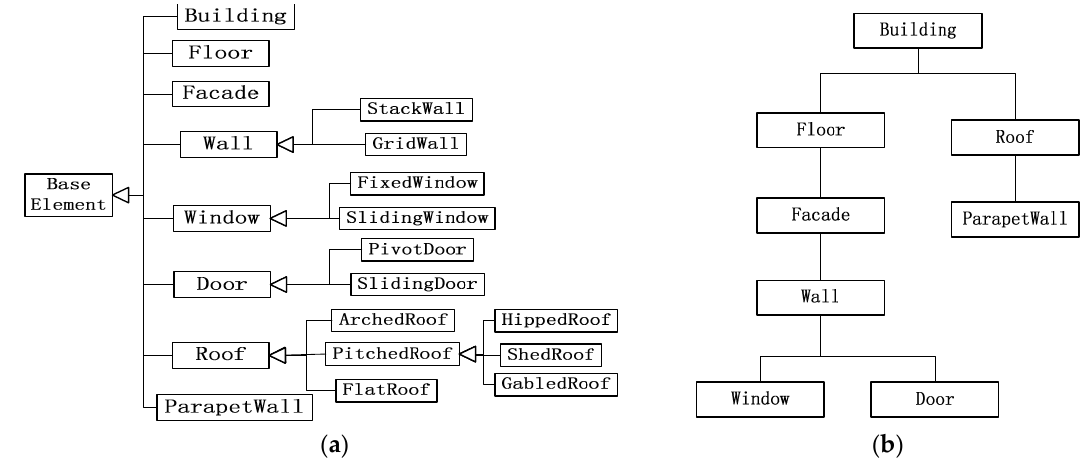
Figure 3. Building base element class and an example of building description: ( a ) building elements class in the framework; and ( b ) relationship between the building element classes.